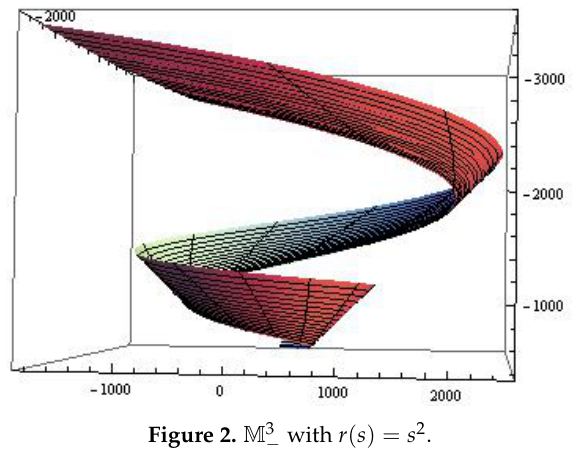
Figure 2. M 3 − with r ( s ) = s 2